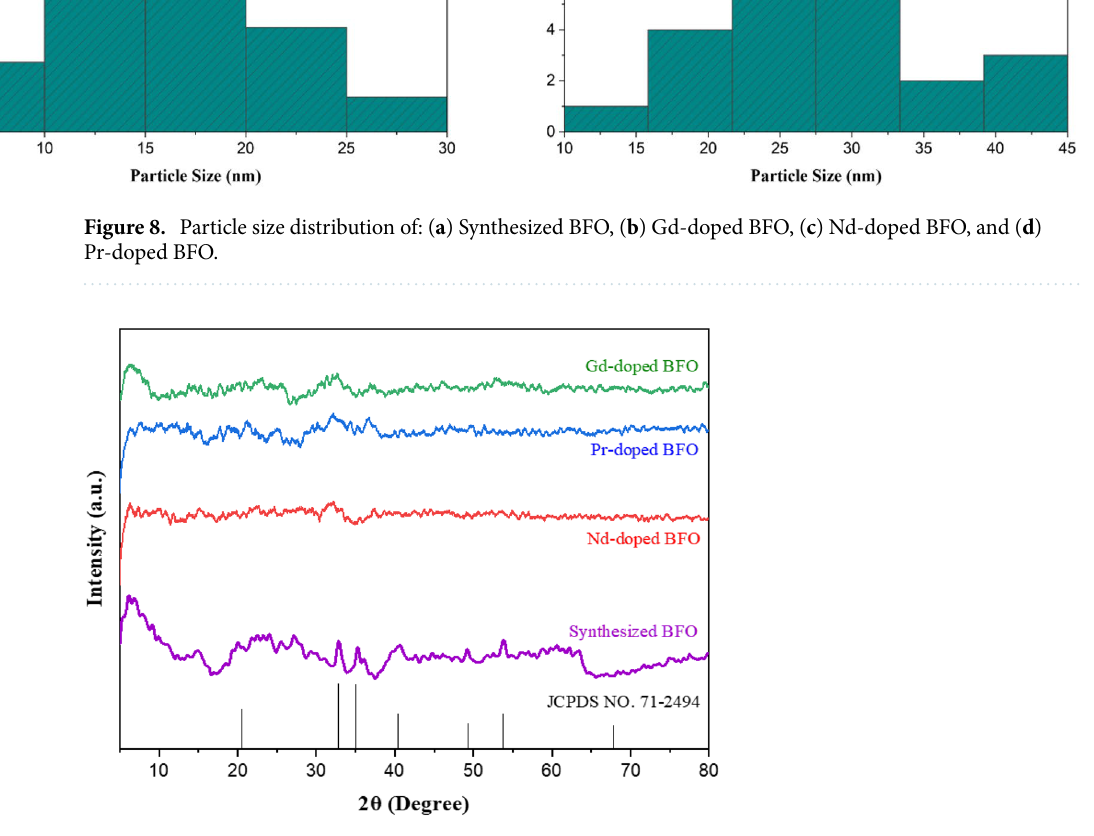
Figure 9. XRD pattern analysis of synthesized bare as well as Nd, Pr, and Gd-doped BiFeO 3